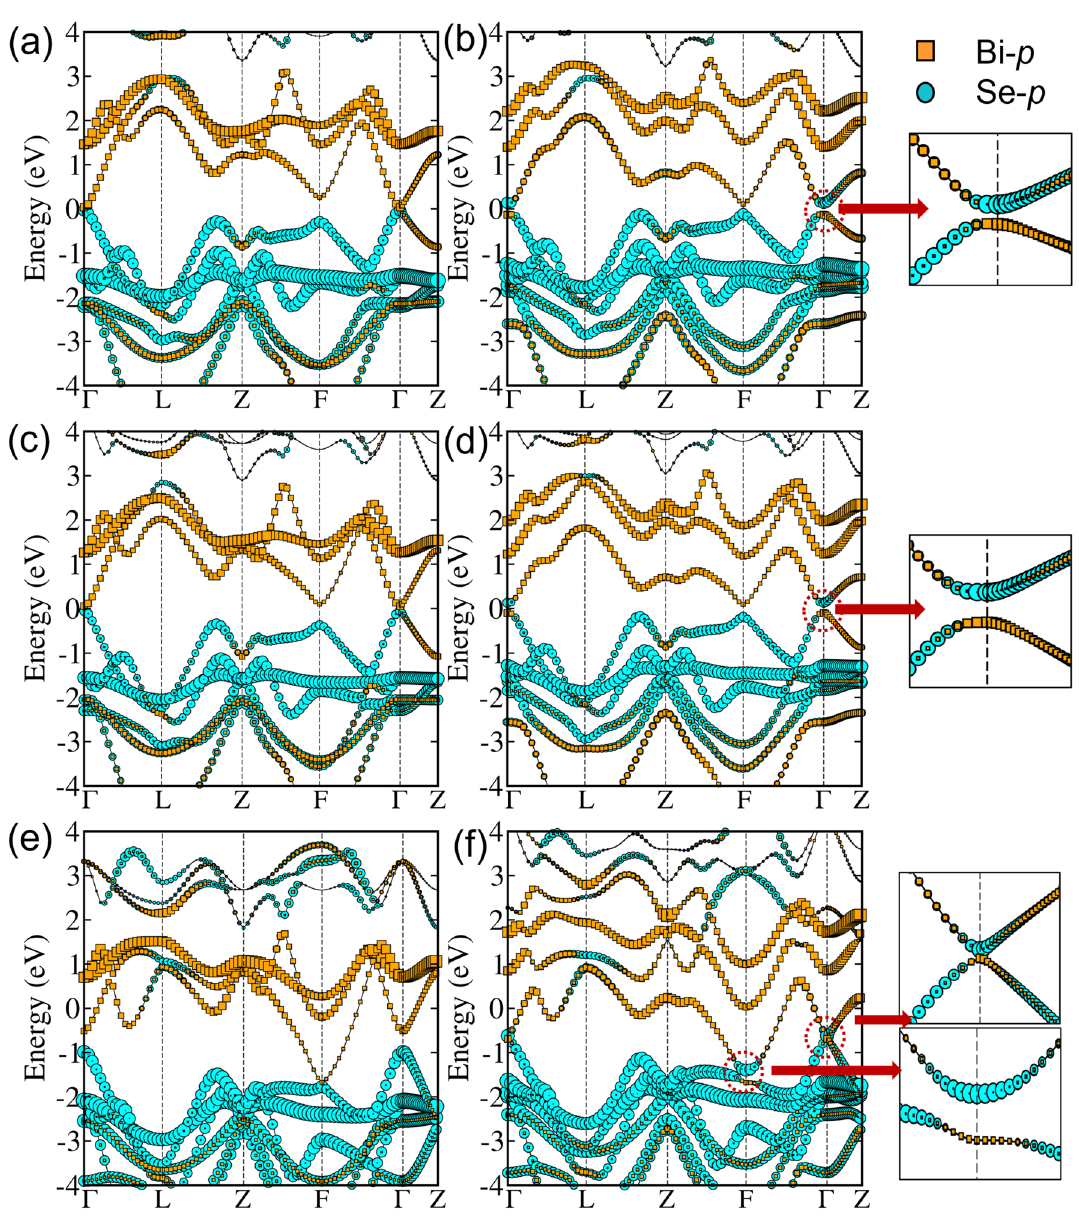
Figure 2. The band structures for TlBiSe 2 , GaBiSe 2 and PbBiSe 2 without SOC are shown in ( a ), ( c ), ( e ) and with SOC are shown in ( b ), ( d ), ( f ), respectively. Insets show band inversion at respective high symmetry